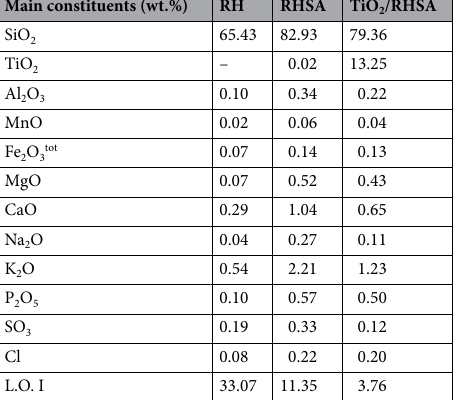
Main constituents